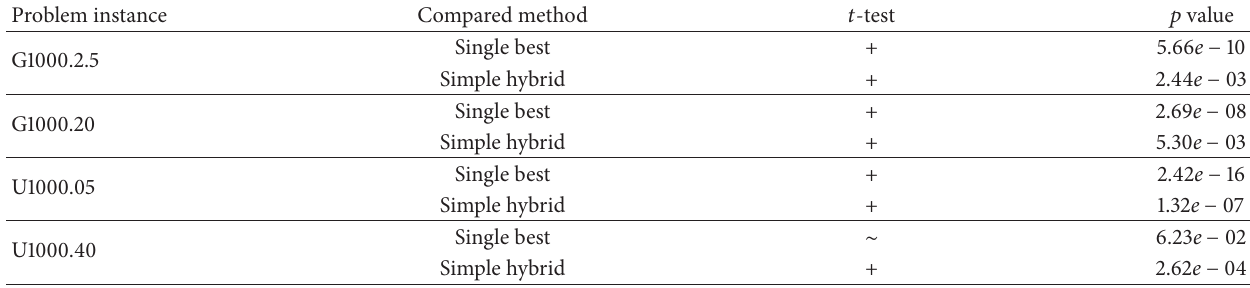
Table 5: Statistical test of graph bisection.